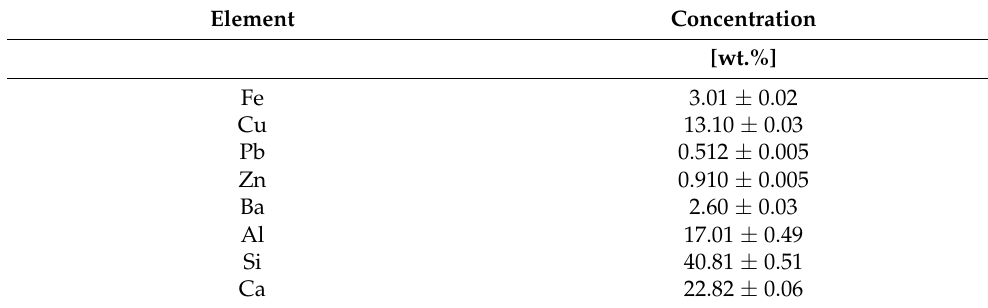
Table 17. Chemical composition (M + NM) of the pyrolytic solid residue phase. Element Concentration